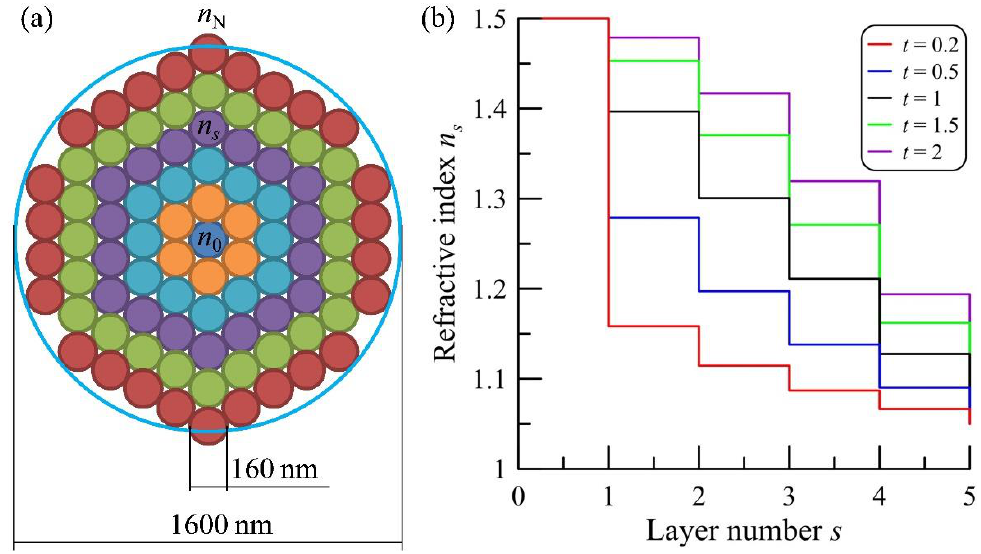
Figure 2. ( a ) Graded-index model of the hexagonally arranged nanofibers; ( b ) Different index grading types of refractive index n s in the graded-index lens.